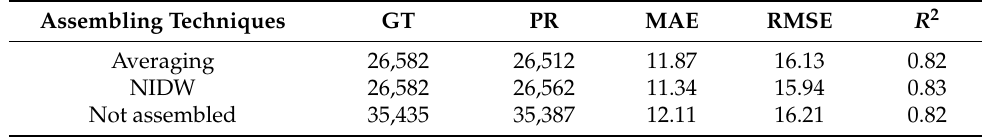
Table 4. The model performance with different assembling techniques on the validation dataset. Assembling